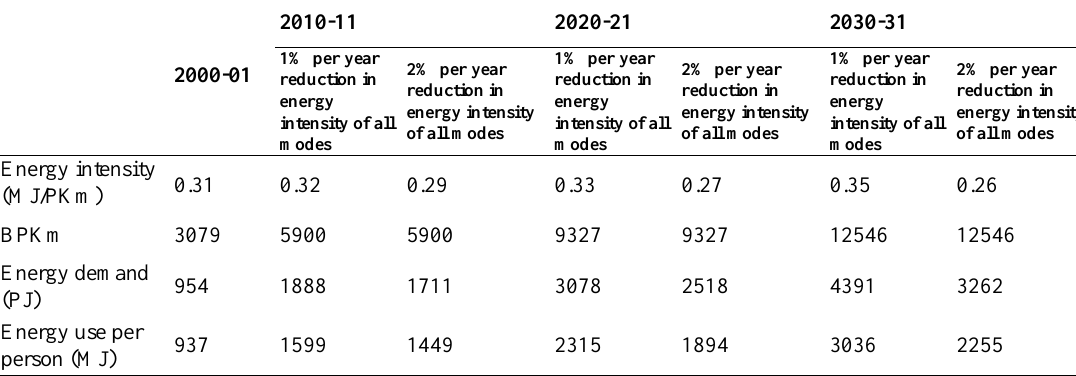
Table 7. Transport energy demand in India; efficiency gain